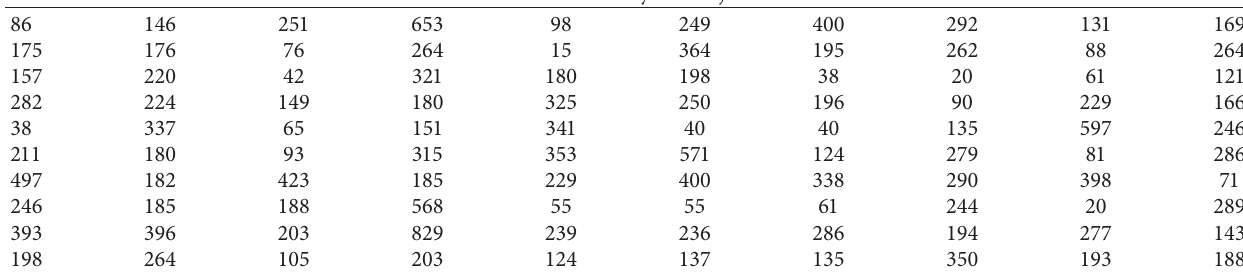
Table 5: Failure time data on 100cm yarn subjected to 2: 3% strain